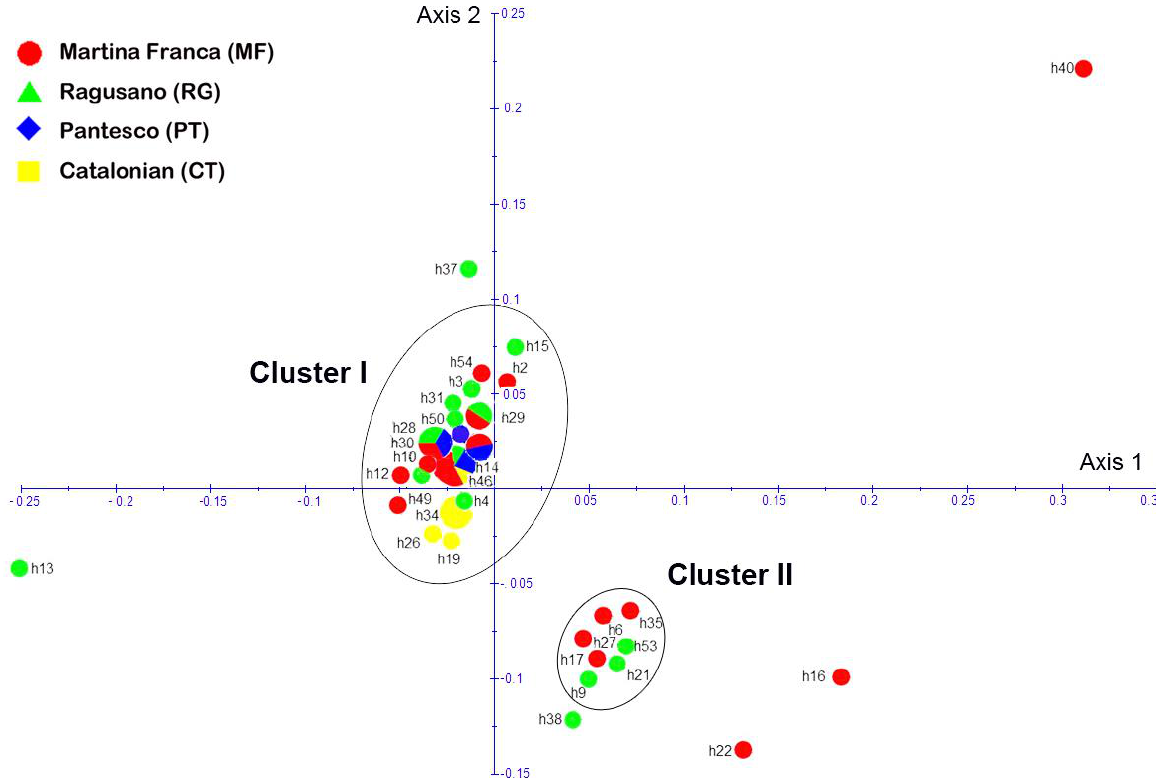
Figure 4. PCoA. The two axes of the PCoA plot were based on the dissimilarity matrix according to Kimura (1980) and generated using DARwin 6.0. Two different clusters, cluster I and cluster II, included most haplotypes of the breeds studied (Martina Franca (MF), Ragusano (RG), Pantesco (PT), Catalonian (CT)). Haplotypes that did not fall into either cluster were MF Hap 22, 37, and 40 and RG Hap 13, 16, and 38.